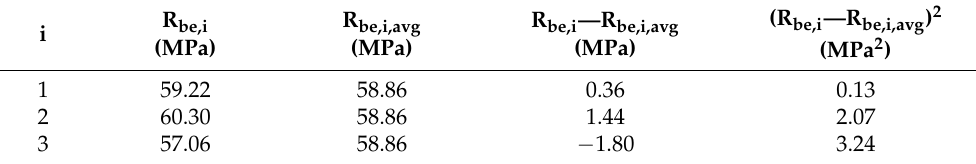
Table 2. Evaluation of Schmidt hammer rebounds.